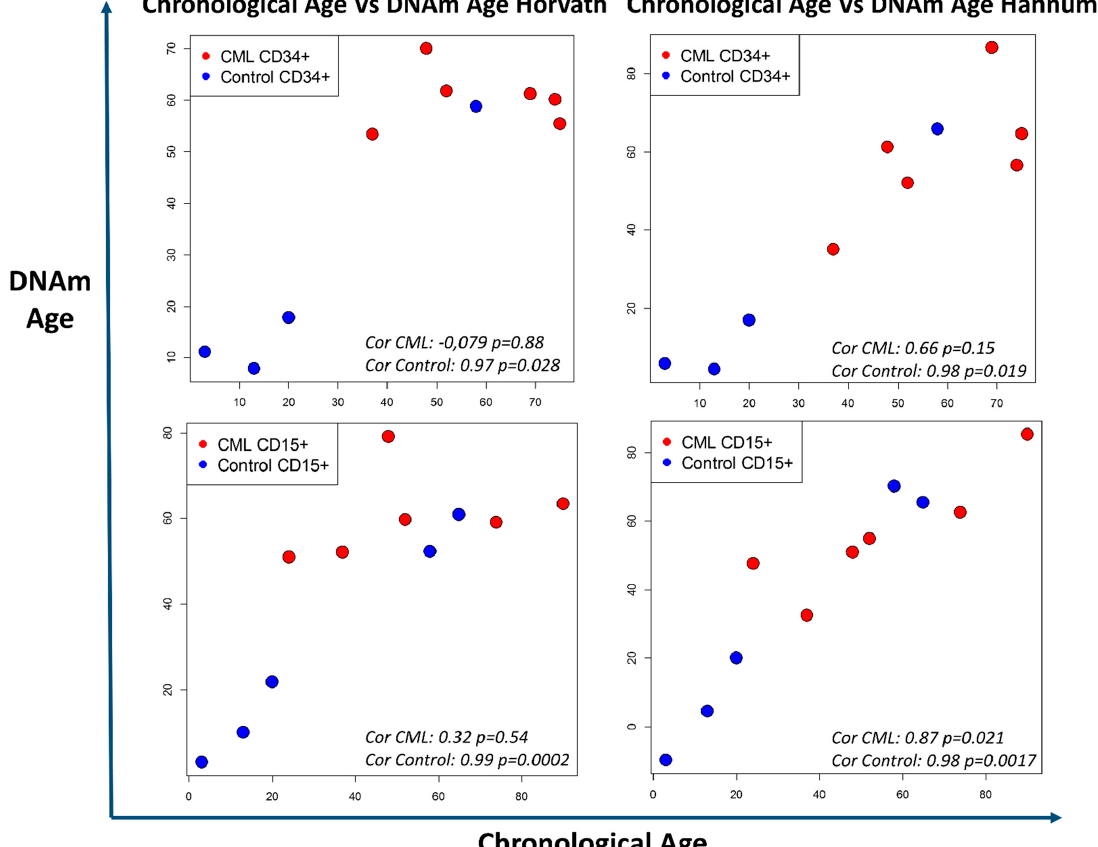
Figure 4. Discrepancy between chronological age and biological age evaluated with two DNA methylation clocks. Methy- lation data (HM450K chip) from Maupetit-Mehouas et al. [77] were analyzed with the DNAm age calculator based on the algorithms described by Horvath [104] and Hannum [105]. The method and R function is described in [104]. Results are presented in graphical form with chronological age (x-axis) versus the DNA methylation (DNAm) age (y-axis) for CD34+CD15- and CD34-CD15+ CP-CML cells at diagnosis (red dots) and control cells (blue dots) from healthy donors. Overall, chronological age and biological age were comparable in control cells. Conversely, biological age was altered in CP-CML samples, particularly in CD34+CD15- cells, showing accelerated cell aging in the youngest patients and a slower cell aging in older patients. Statistical test: Pearson correlation test.